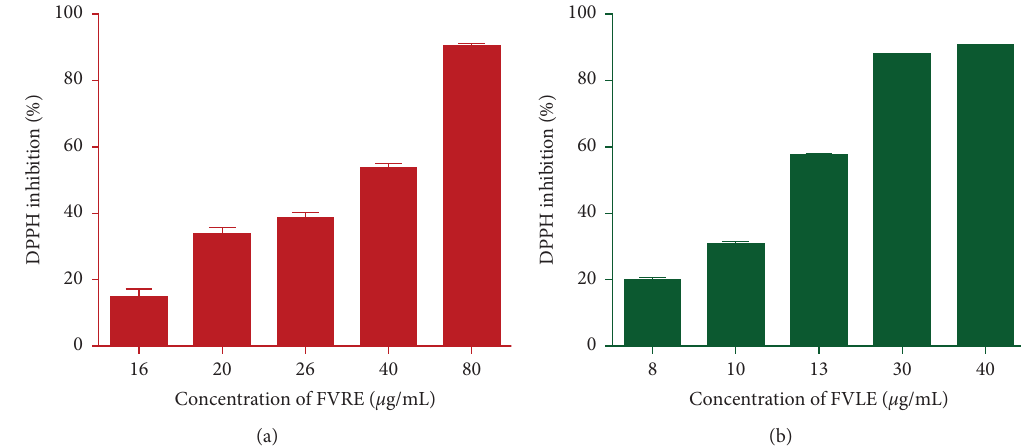
Figure 1: DPPH radical scavenging activity of F. vulgare leaf and rootstock aqueous extracts. The values are the mean of three deter- minations ± standard error. Table 2: IC 50 values of FV aqueous extracts on DPPH and ABTS scavenging activity.